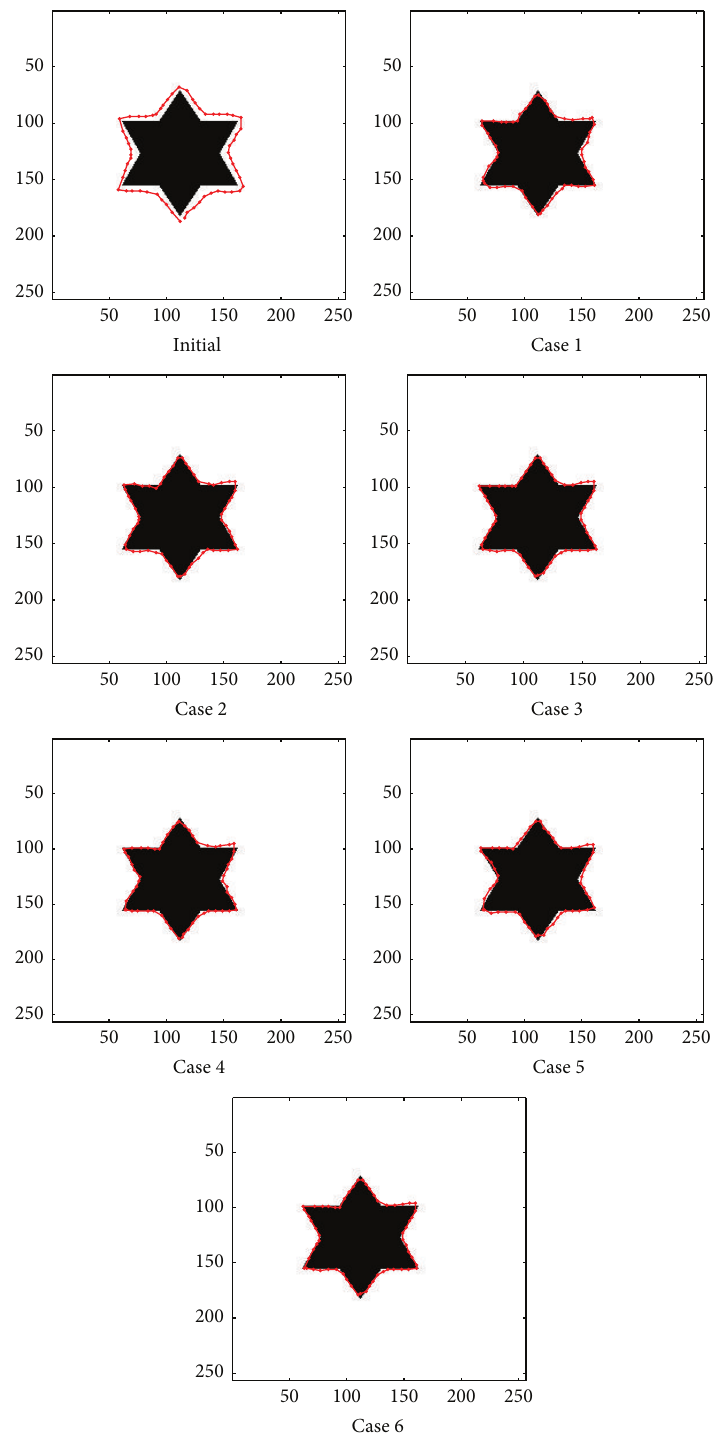
Figure 12: Active contour model implementation by “multipopulation PSO” method for different cases of inertia. Results for “Star” image with control points = 60, 𝛼 = 0.05 , 𝛽 = 0.025 , and Γ = 0.16